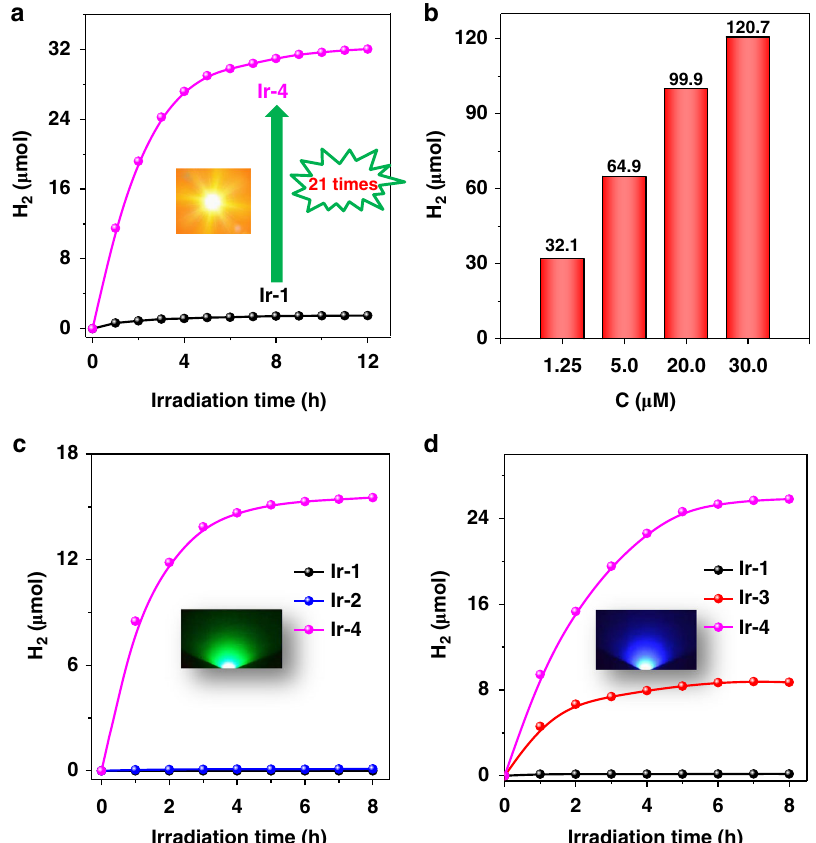
Fig. 2 Photocatalytic hydrogen evolution. Photocatalytic hydrogen evolution with irradiation of a Xe lamp ( λ > 420 nm, 175 W), b Xe lamp ( λ > 420 nm, 175 W) for different concentrations of Ir-4 , c 525 nm and d 450 nm light-emitting diode with light intensity of 100 mW cm − 2 . Conditions: catalyst (50.0 μ M), PS (1.25 μ M) and DMT (0.01 M) in CH 3 CN/H 2 O (v/v =